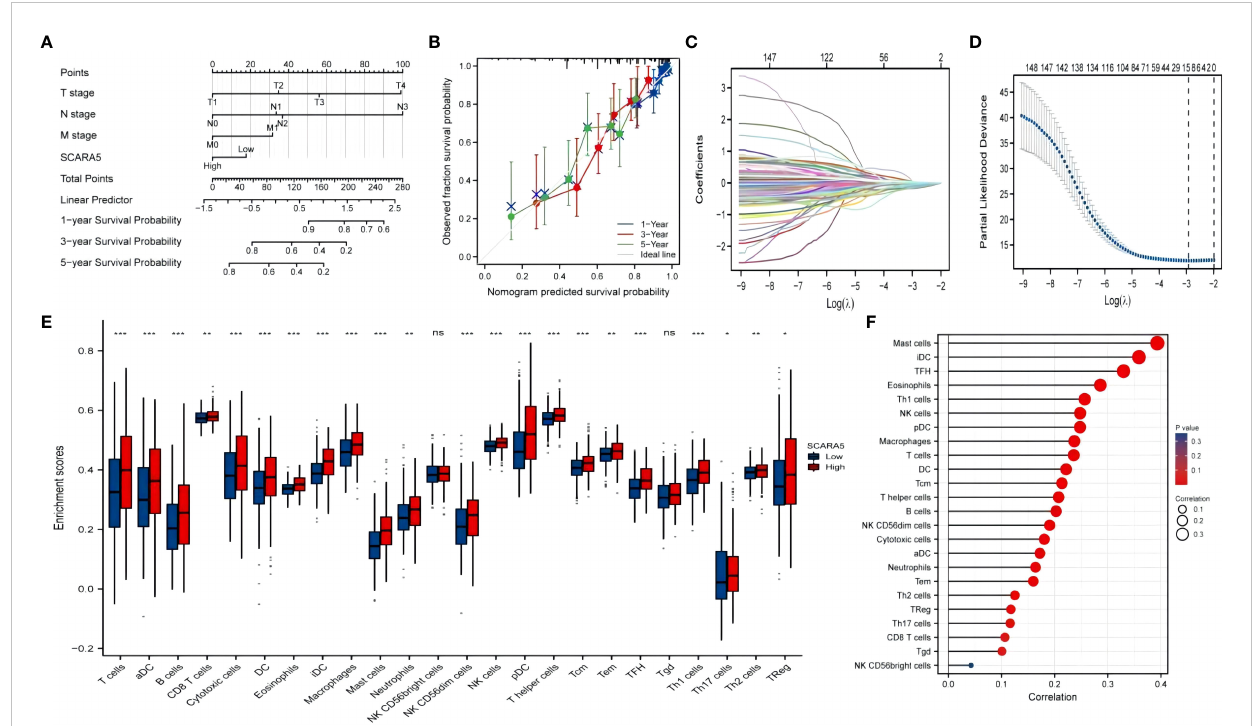
FIGURE 9 Bioinformatics were used to analyze the prognosis of scavenger receptor class A member 5 ( SCARA5 ) and its correlation with immune in fi ltration. The “ rms ” package and the “ survival ” package were used to predict the prognosis of SCARA5 at 1, 3, and 5 years after the onset of SKCM (A) . (B) shows calibration visualization. The abscissa is the survival probability predicted by the model, the ordinate is the actual observed survival probability, and the gray diagonal line is the ideal line. The lines and points of different colors (except for the gray diagonal line) represent the predictions of the model at different time points. When the lines of different colors are closer to the ideal gray line, and the error bar is smaller (stable), this indicates that at this time point the prediction effect is better. Differential genes in the GSE100050 data set were selected and the “ glmnet ” package used to draw a Lasso coef fi cient screening diagram and simultaneously plot the Lasso variable trajectory (C, D) . Gene Set Variation Analysis (GSVA) package and immune in fi ltration algorithm ssGSEA (GSVA package built-in algorithm) were used to map SCARA5 and SKCM with 24 kinds of immune cells [aDC (activated DC); B cells; CD8 T cells; cytotoxic cells; DC; eosinophils; iDC (immature DC); macrophages; mast cells; neutrophils; NK CD56bright cells; NK CD56dim cells; NK cells; pDC (Plasmacytoid DC); T cells; T helper cells; Tcm (T central memory); Tem (T effector memory); Tfh (T follicular helper); Tgd (T gamma delta); Th1 cells; Th17 cells; Th2 cells; Treg]